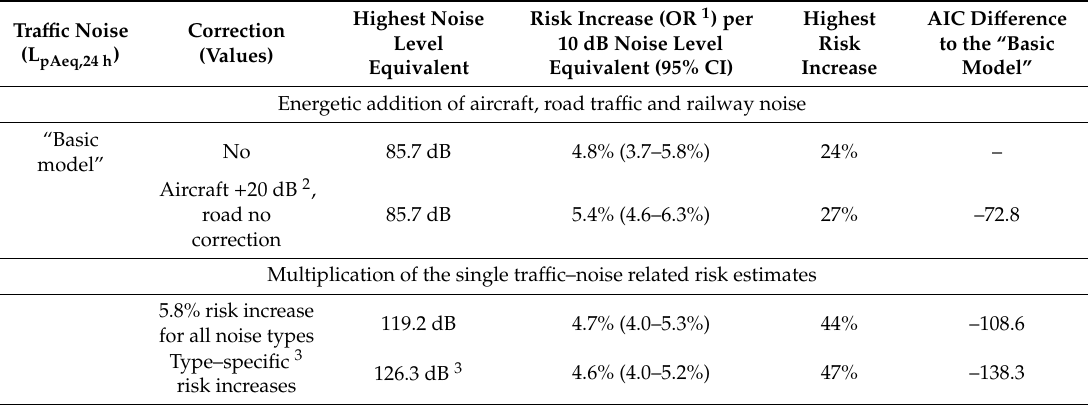
Table 3. Risk increase for depression per 10 dB noise level equivalent ( starting point: 40